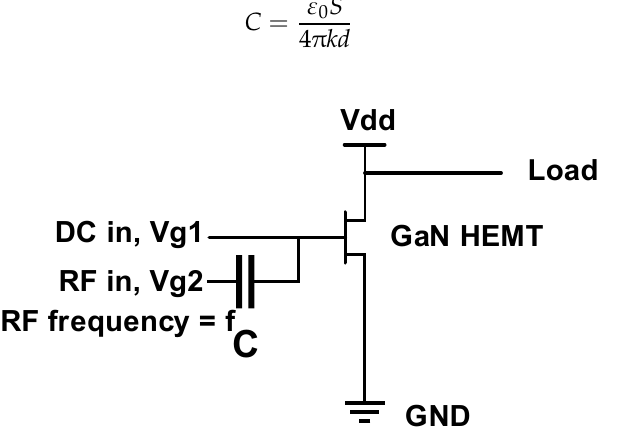
Figure 6. One-tone load-pull schematic for measurements.